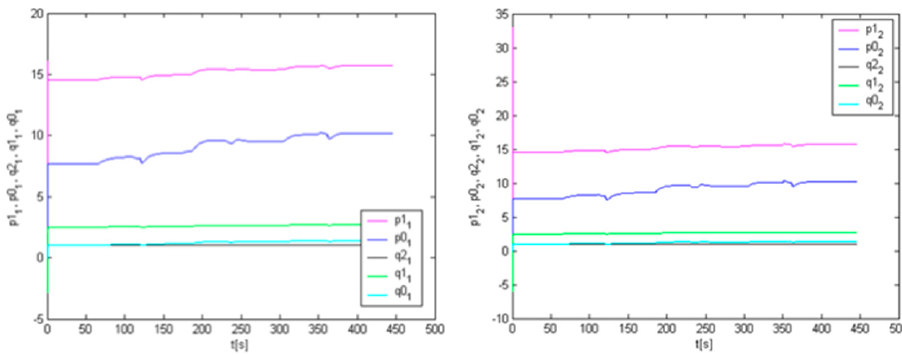
Figure 7. Output of control .